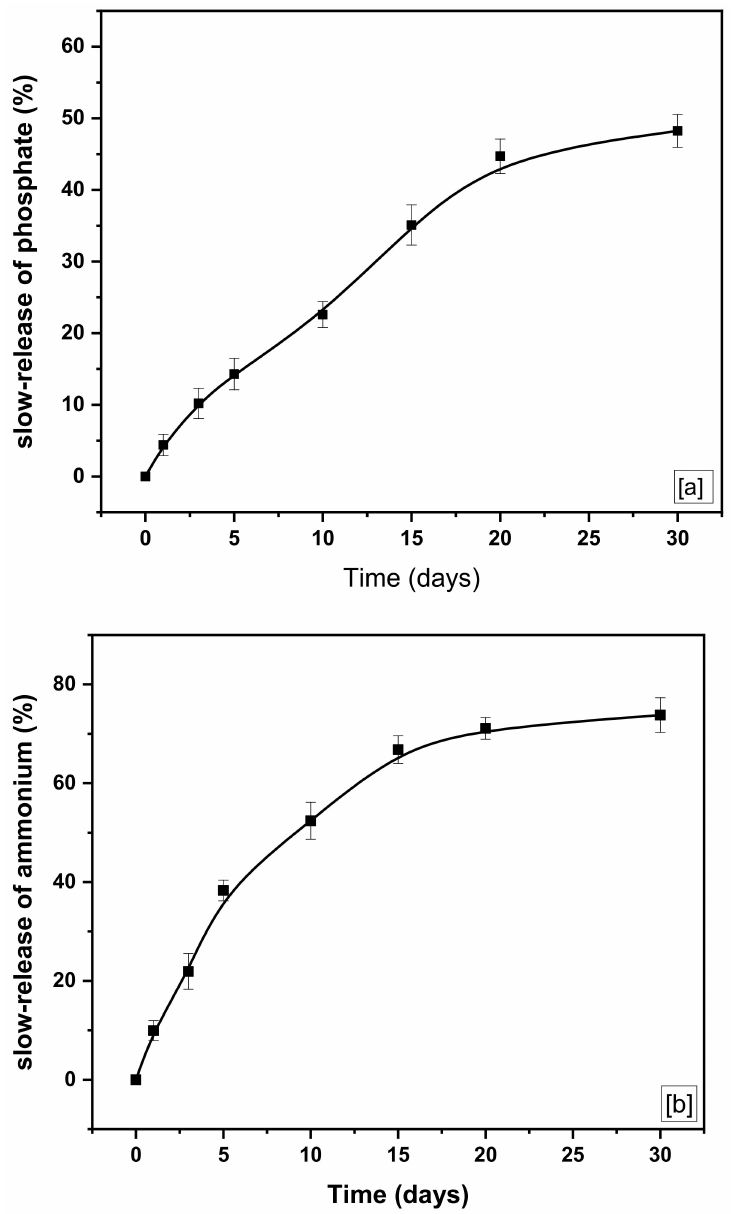
Figure 9. ( a ) Phosphate and ( b ) ammonium release from f -MB into the soil. The first stage released about 14.3 wt% of the phosphate ions (H 2 PO 4 − and HPO 42 − ) within 5 days. The second stage (from 5 to 15 days) is confirmed by a slower rate of P release, with approximately 20.8 wt% of the phosphate released within these 10 days.